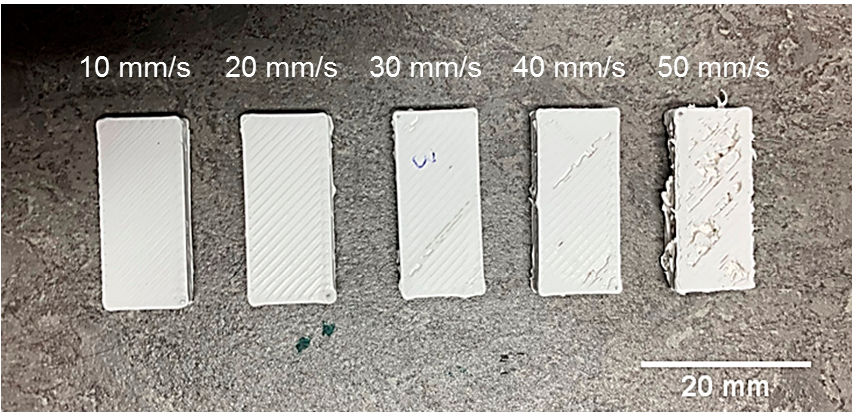
Figure 3. 3D printed test samples using printing speeds of 10–50 mm/s.